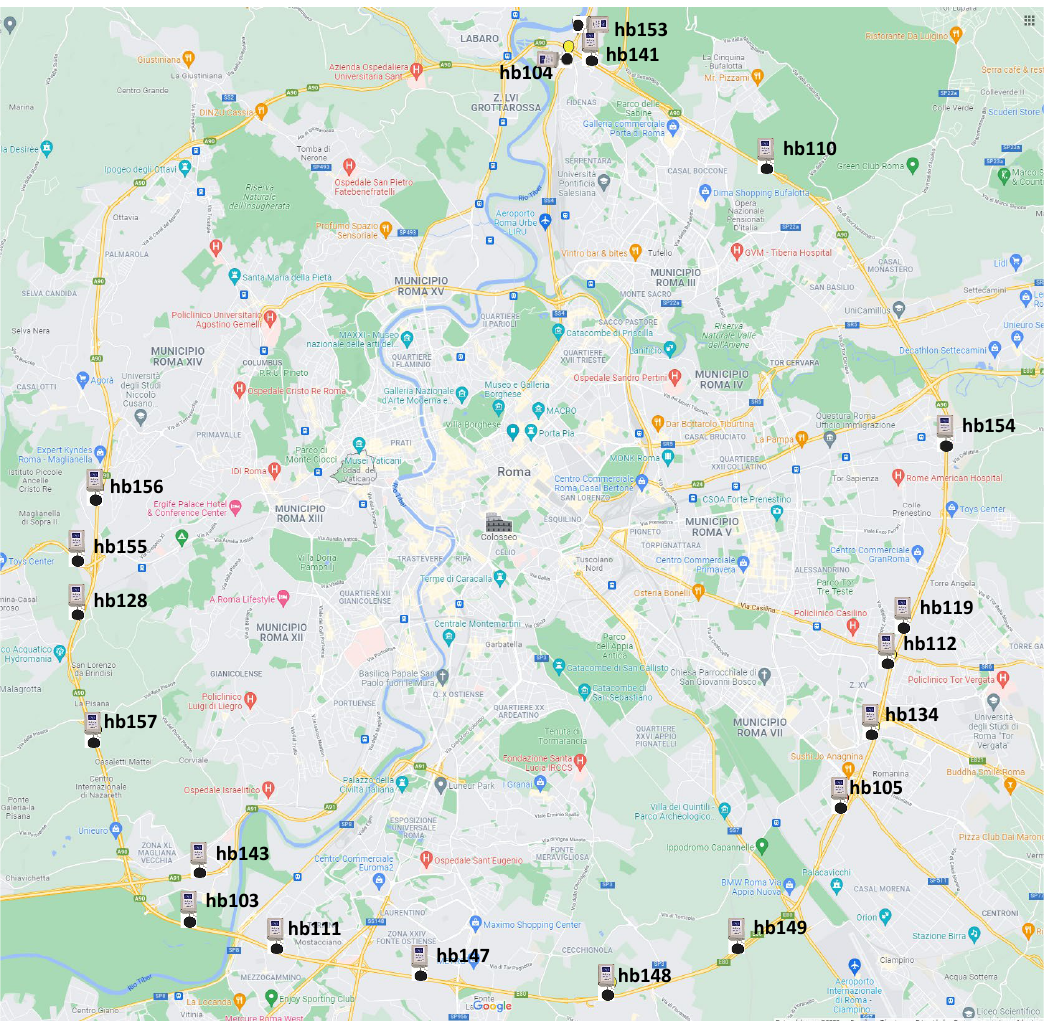
Figure 2. Map of the acoustic sensor locations of the WASN deployed across A90 circular highway surrounding the city of Rome (suburban environment), adapted from Google Maps ®